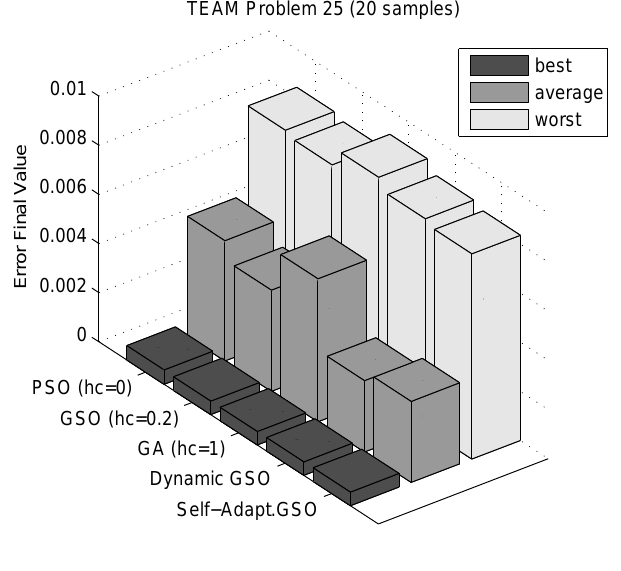
Final fitness values for TEAM problem 25 optimized with different GSO